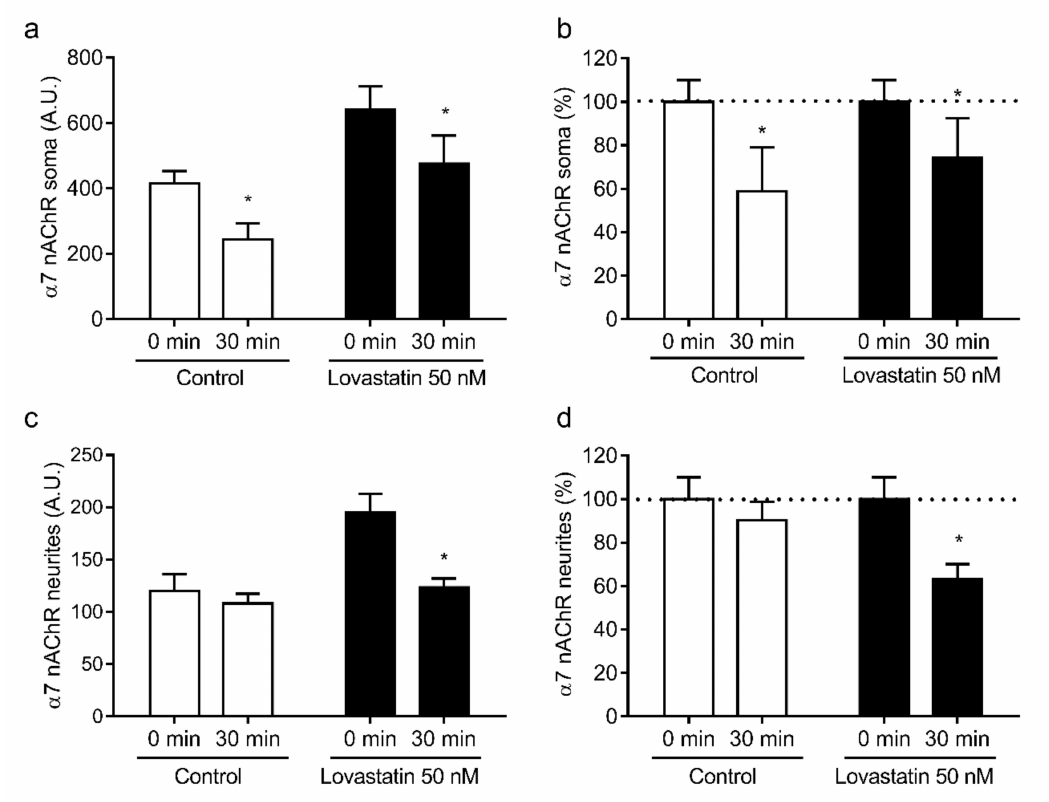
Figure 6. Lovastatin treatment a ff ects surface α 7 nAChR internalization di ff erentially in soma and neurites. Cultured hippocampal neurons were treated with 50 nM lovastatin for a total of 14 days or